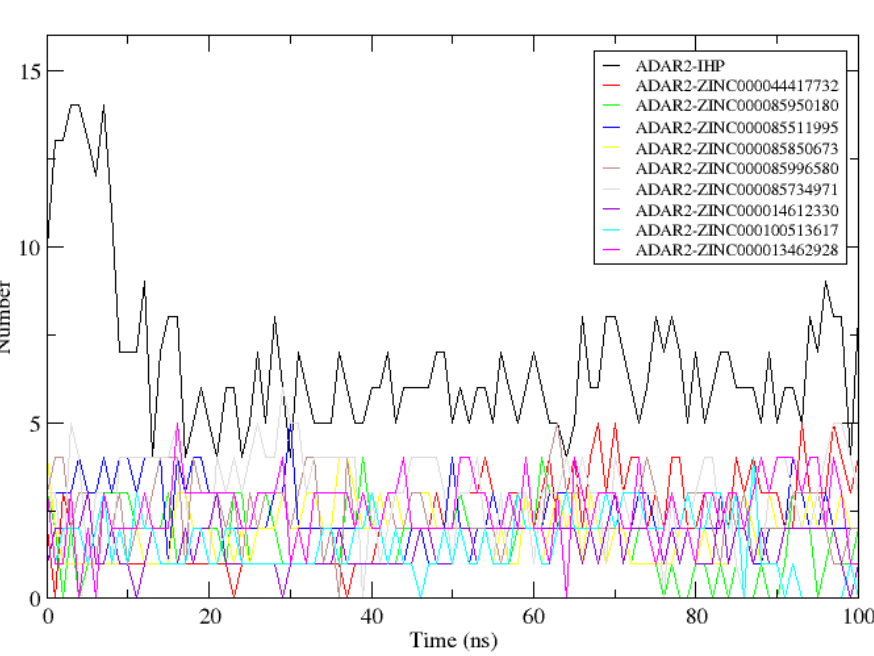
Figure 7. Hydrogen bond analyses of each ADAR2-ligand complex throughout the 100 ns MD simulation. For the ADAR2-IHP complex, 10 hydrogen bonds were within the 0.35 nm distance and 30 ◦ angle threshold as predicted via GROMACS although 12 were identified from the protein–ligand interaction profile. The 12 hydrogen bonds were formed with residues Arg400 (2 H-bonds), Arg401 (2 H-bonds), Lys519 (2 H-bonds), Arg522, Tyr658, Trp687, Val688, Glu689, and Lys690. At 4 ns, the hydrogen bond interactions increased to 14, after Lys690, and Gln694 were